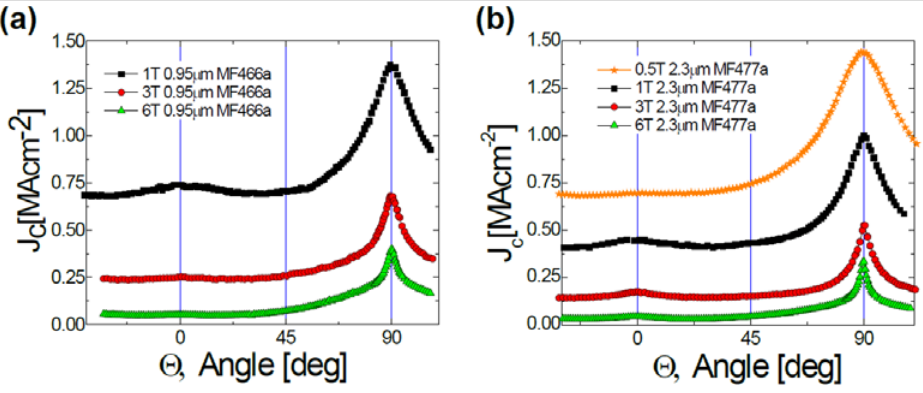
Figure 4. ( a ) Measurement of the J characteristics at 75.5 K as a function of magnetic c field strength and applied field orientation for a 0.95 μ m thick film; and ( b ) a 2.3 μ m thick